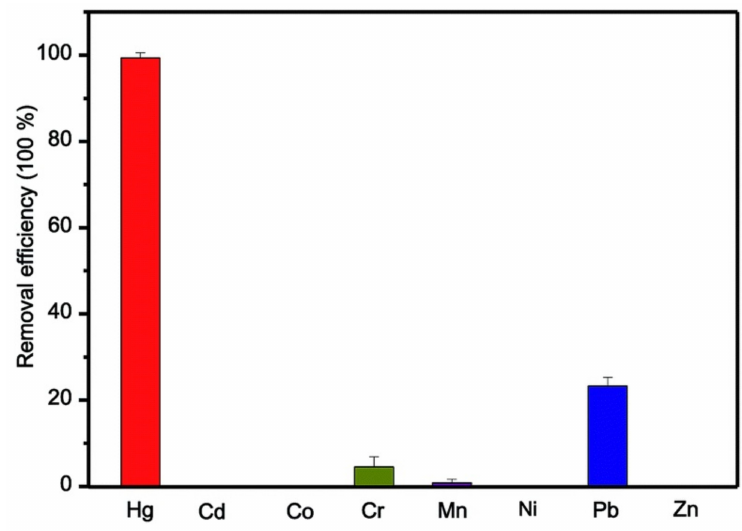
Figure 13. Selectivity of bi-I-functionalized Fe 3 O 4 @SiO 2 @HKUST-1 for Hg 2+ conditions: each ion of 10 mg L − 1 and pH 3 (reproduced with the permission from Ref